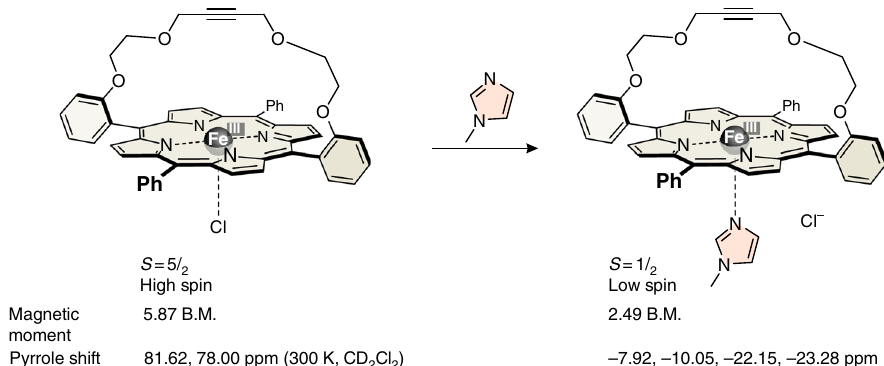
Fig. 3 A strapped porphyrin as a model compound. A strapped porphyrin was used to model the properties of a 5-coordinate Fe(III) porphyrin with one strong axial nitrogen ligand. The 1 H NMR pyrrole shifts and the effective magnetic moment indicate that the chloride complex is high spin and the 1:1 imidazole complex is low